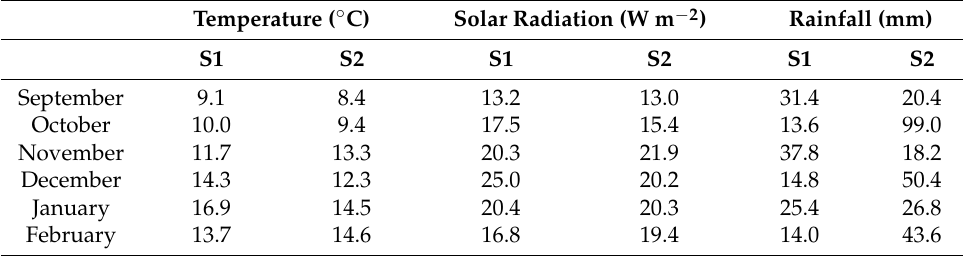
Table 2. Mean monthly climate data for season one (2019–2020) and season two